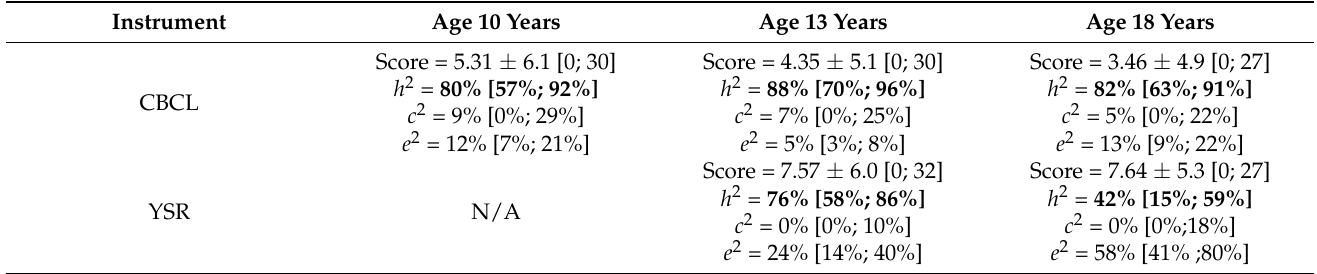
Figure 1. Phenotypic development of externalizing behavior throughout adolescence. Measurements are based on the externalizing scale of the Child Behavior Checklist and Youth Self Report. Data points are plotted for the untransformed scores on the y-axis. Estimates of sex and age regression coefficients and p -value were obtained from the longitudinal genetic model on the log 10 -transformed scores. Abbreviations (in alphabetical order): CBCL = child behavior checklist; CI = confidence interval; n.s. = not significant; YSR = youth self-report. Table 1. Externalizing behavior on the Child Behavior Checklist (CBCL) and Youth Self Report (YSR).